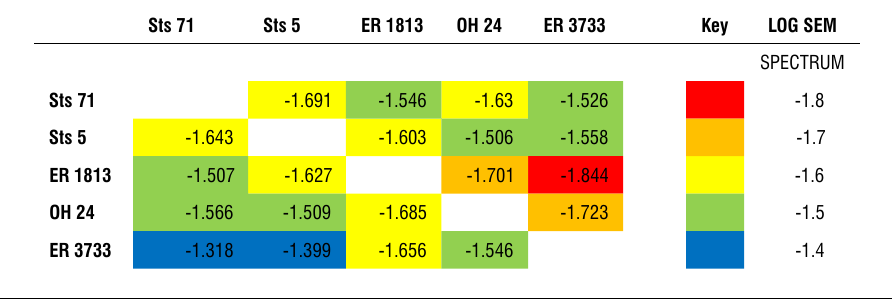
Log sem values for pairwise comparisons of five Plio-Pleistocene hominin crania, dated between 1.6 and 2.5 million years ago. The mean log sem for the entire database is -1.59±0.12 which is almost identical to the values for conspecific comparisons of modern Pan paniscus (-1.61±0.1) and for P. troglodytes